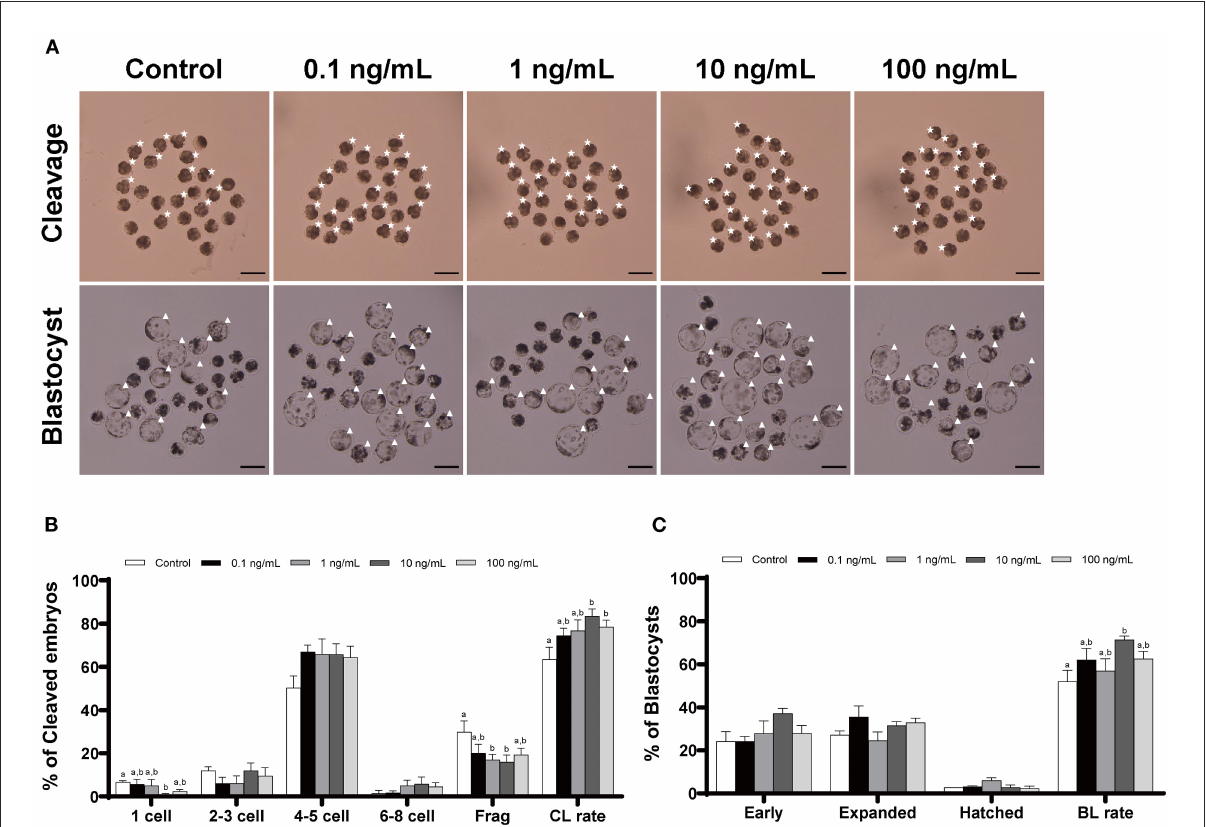
FIGURE2 Effect of IL-7 supplementation during IVC on the cleavage and blastocyst formation patterns of PA embryos. (A) Representative image of the morphology of cleaved embryos and blastocysts from each group after PA. Asterisk, cleaved embryo; Triangle, blastocyst. Scale bar: 200 µ m. The cleavage pattern (B) and blastocyst formation (C) rate of PA embryos. Within each endpoint, bars with different letters (a, b) indicate significant differences ( p < 0.05) at various IL-7 concentrations. Frag, fragmentation; CL, cleavage; BL, blastocyst. The cleavage and blastocyst formation rates were evaluated on Day 2 and 7 after PA, respectively. For all graphs, values represent the mean ± SEM. The experiment was replicated four